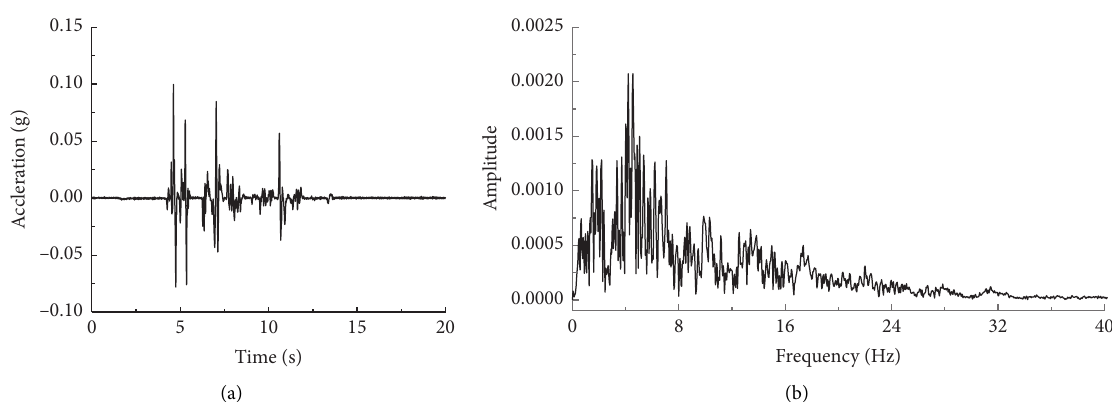
Figure 7: EL wave excitations during testing. (a) Acceleration process of all waves. (b) Fourier spectra of all